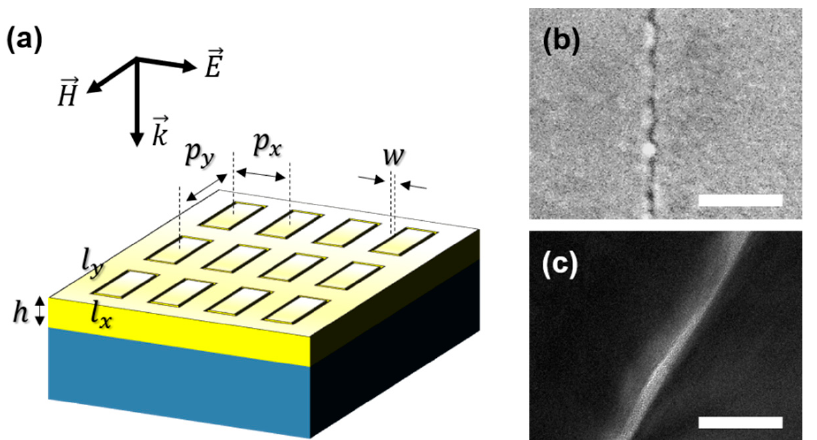
Figure 3. ( a ) Overview of the fabricated nano-trench array on Au film on a silicon substrate. In our sample, w = 1.5 nm, px = 20 μ m, py = 50 μ m, lx = 10 μ m, ly = 40 μ m, h = 250 nm. Polarization is sample, w = 1.5 nm, px = 20 µ m, py = 50 µ m, lx = 10 µ m, ly = 40 µ m, h = 250 nm. Polarization